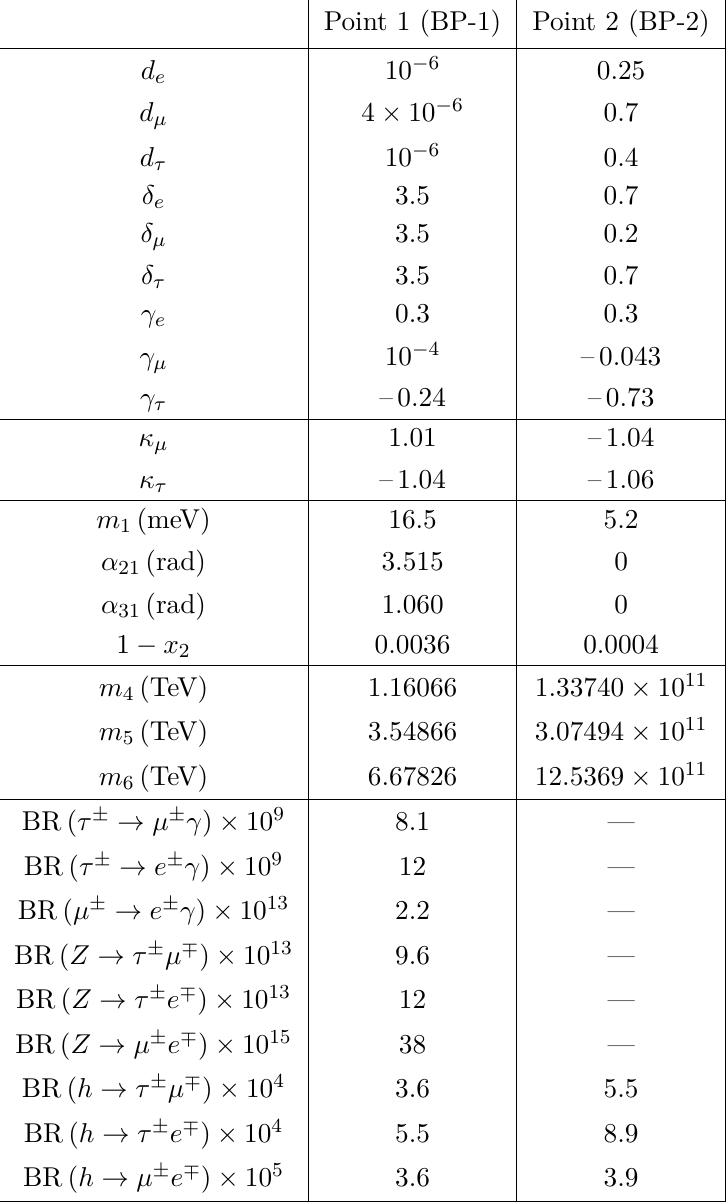
Table 3 . Two benchmark points. In the third column, the symbol ‘—’ stands for a tiny number . 10 − 20 . The values of the input parameters absent from the first column are given at the beginning of subsection